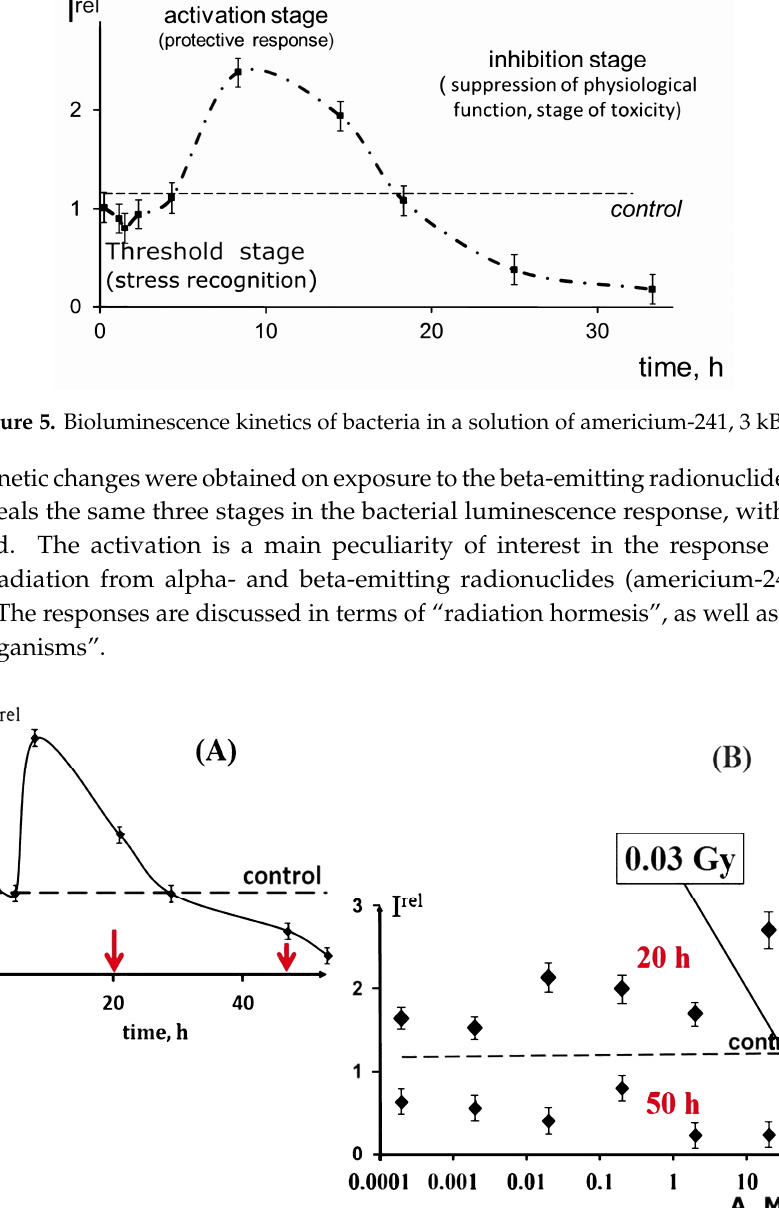
Figure 5. Bioluminescence kinetics of bacteria in a solution of americium-241, 3 kBq/L.